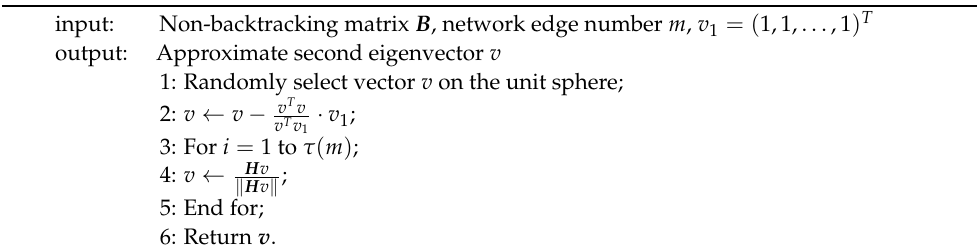
Algorithm 1: Approximate feature vector algorithm